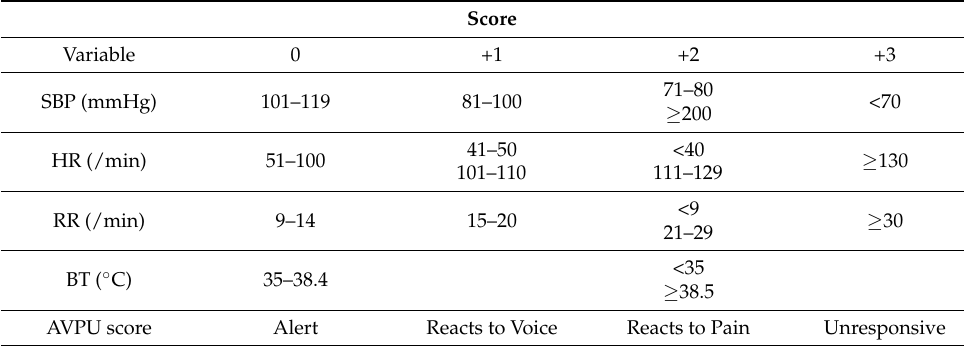
Table 4. Modified Early Warning Score (MEWS)